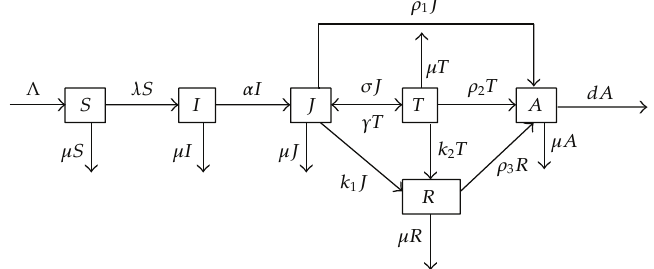
Figure 1: Relationship between di ff erent